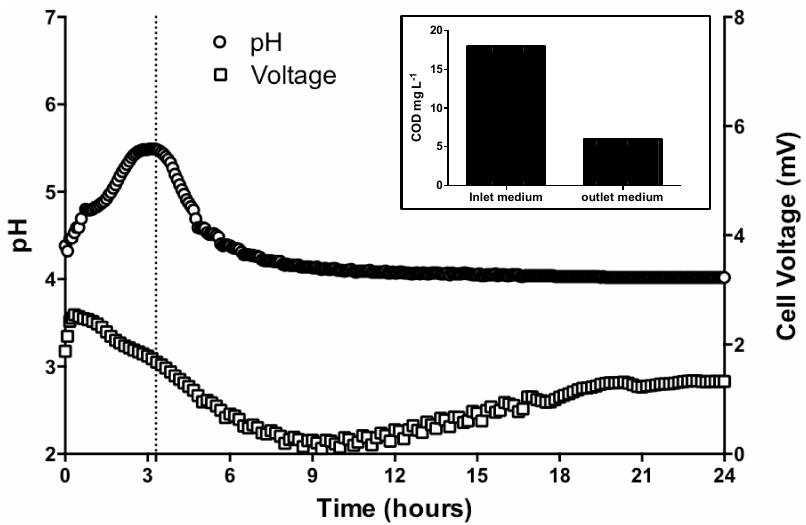
Figure 2. pH increase and sCOD removal in continuous ‐ flow assays in SC MFC reactors. MFC had been previously inoculated with the enriched culture of microorganisms taken from an AMD ‐ affected sediment obtained in the Lluta river watershed, Northern Chile. A line is shown at level of 3.3 h to reference the beginning of pH decrease. The data set is representative of multiple replicates of the experiment.